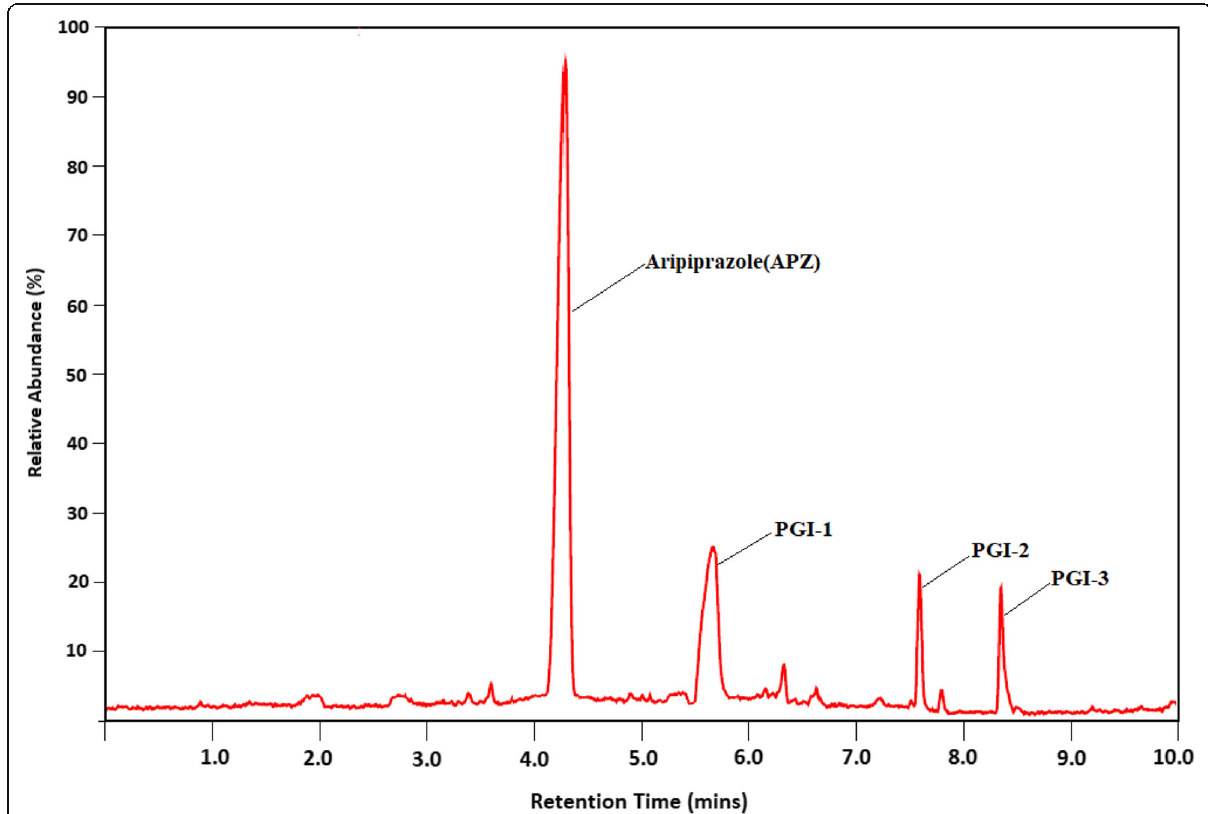
Fig. 3 TIC chromatogram of APZ and PGIs